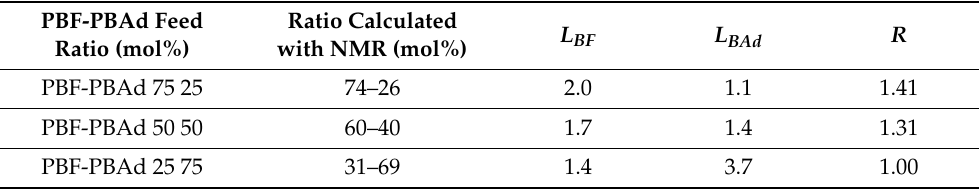
Table 2. Comonomer ratio in the feed calculated with NMR, as well as the block length and degree of randomness of the PBF-co-PBAd